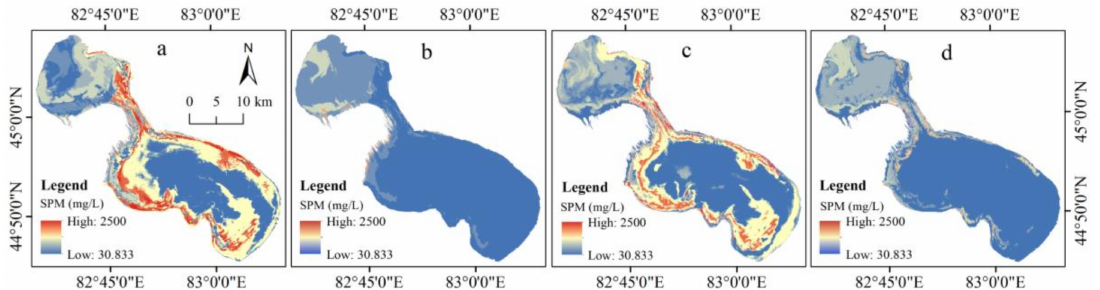
Figure 10. Retrieval of SPM from the original images: ( a ) Landsat 8_RF; ( b ) Landsat 8_XGBoost; ( c ) Sentinel 2_RF; ( d ) Sentinel 2_XGBoost.